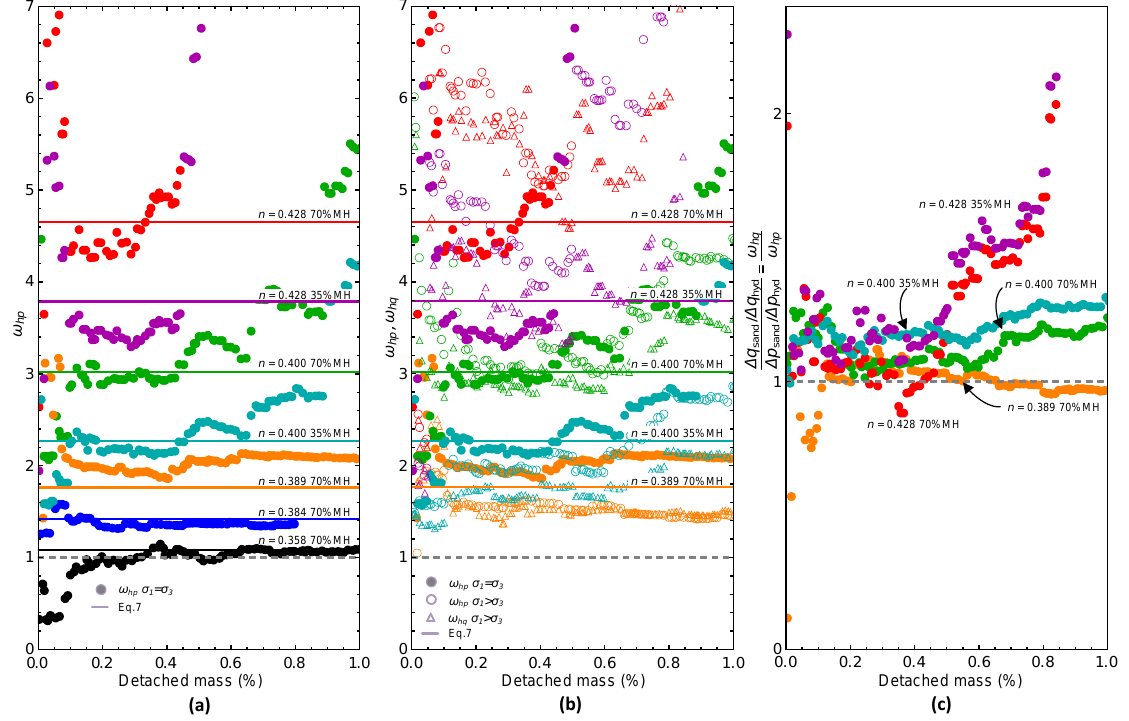
Figure 9. Comparison between spherical and deviatoric influence of MH on stress relaxation. Colors represent different porosity and MH participation factors: ( a ) spherical relaxation (dots = DEM results, lines = Equation (7)); ( b ) spherical and deviatoric relaxation, represented by circles and triangles, respectively; samples stressed isotropically and deviatorically are marked by filled and hollow markers, respectively (dots = DEM results, lines = Equation (7)); ( c ) ratio of ω hq to ω hp